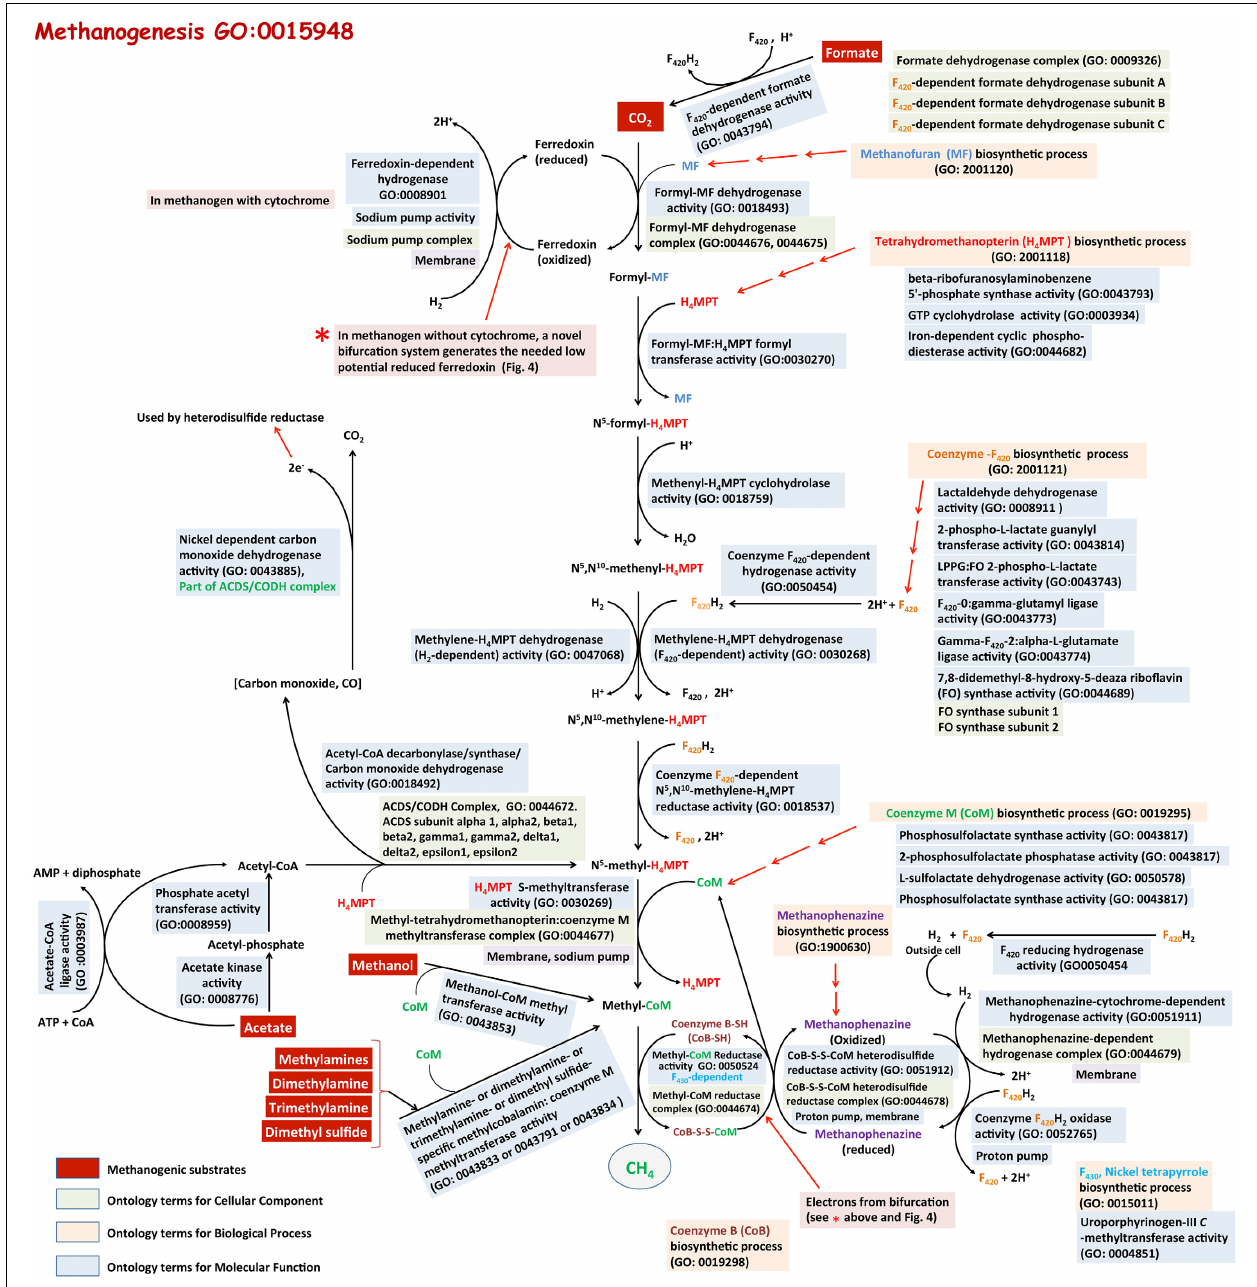
FIGURE 4 | Methanogenesis from various substrates, and relevant GO terms. Methanogenic substrates (shaded in red) are biologically converted to methane by methanogenic archaea. This pathway requires several unique coenzymes. Biosynthesis processes of these coenzymes are also described in GO (shaded in beige). Color codes for three ontologies: